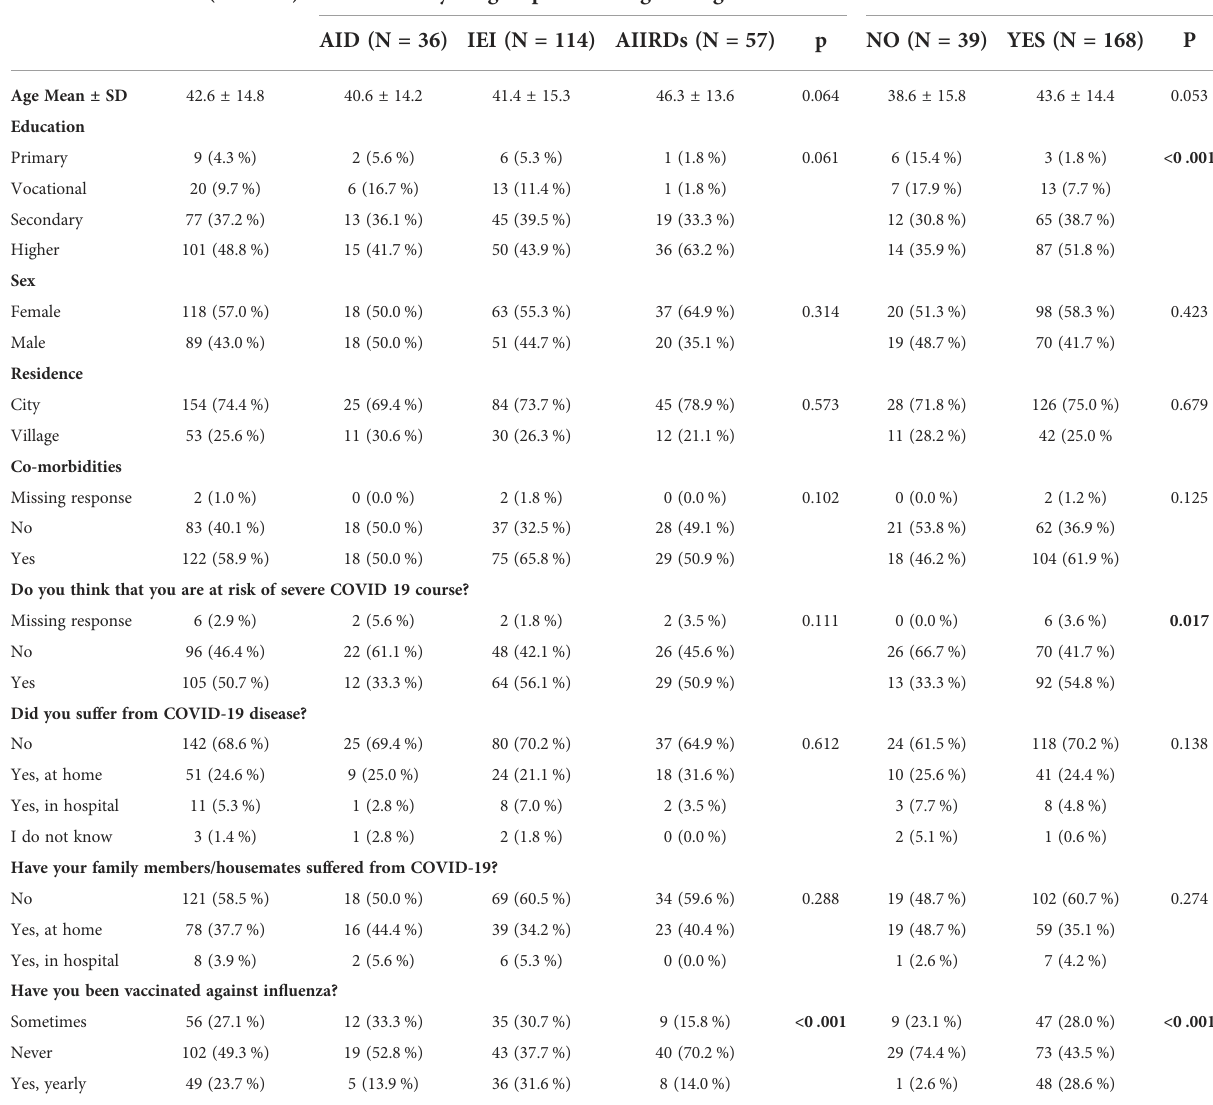
TABLE 2 Comparisons of select features among the study groups. Total (N = 207) Analyzed groups according to diagnosis Vaccination